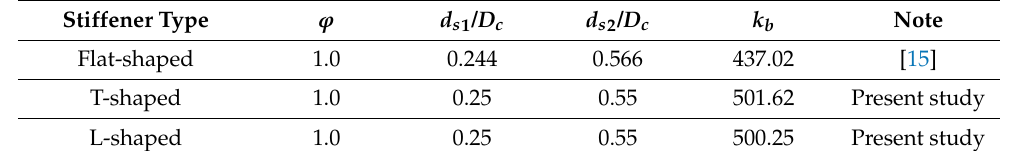
Table 1. Optimal values for two longitudinal stiffeners for both cross-section types.